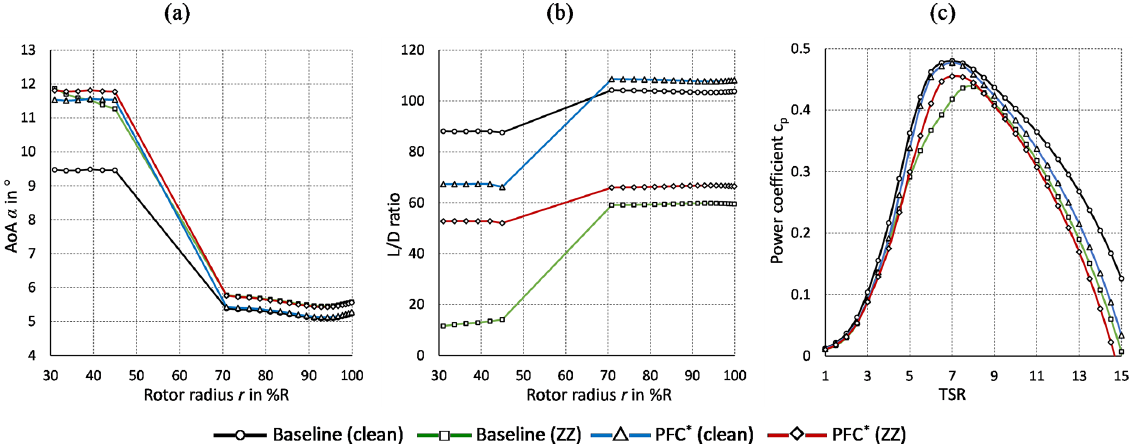
Figure 18. Rotor blade performance simulation of the baseline and the new design application. (a) AoA over rotor radius at λ opt = 7. (b) L/D over rotor radius at λ opt = 7. (c) Power coefficients over TSR.